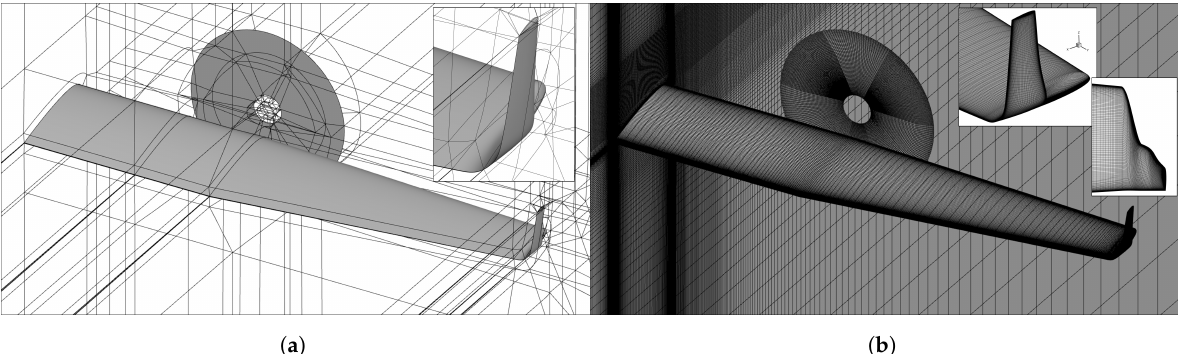
Figure 26. Modified computational grid used in FVM computations with tip winglet: ( a ) blocking topology with detail of the winglet region; ( b ) wing surface and symmetry plane mesh, with detail of the winglet